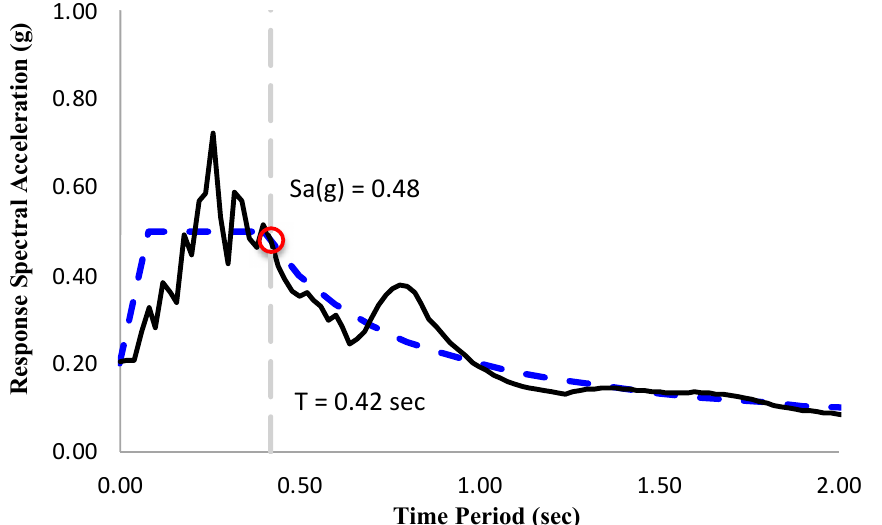
Figure 8. Scaled acceleration response spectrum of Northridge-1994 for base motions.